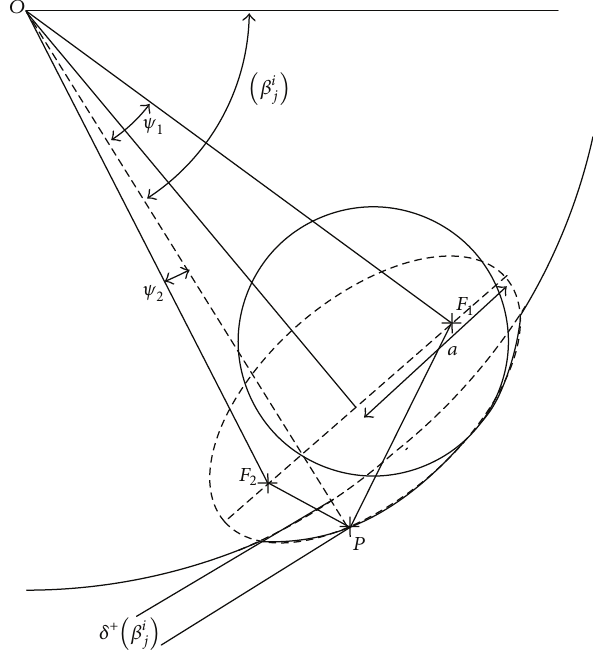
Figure 20: Defect depth